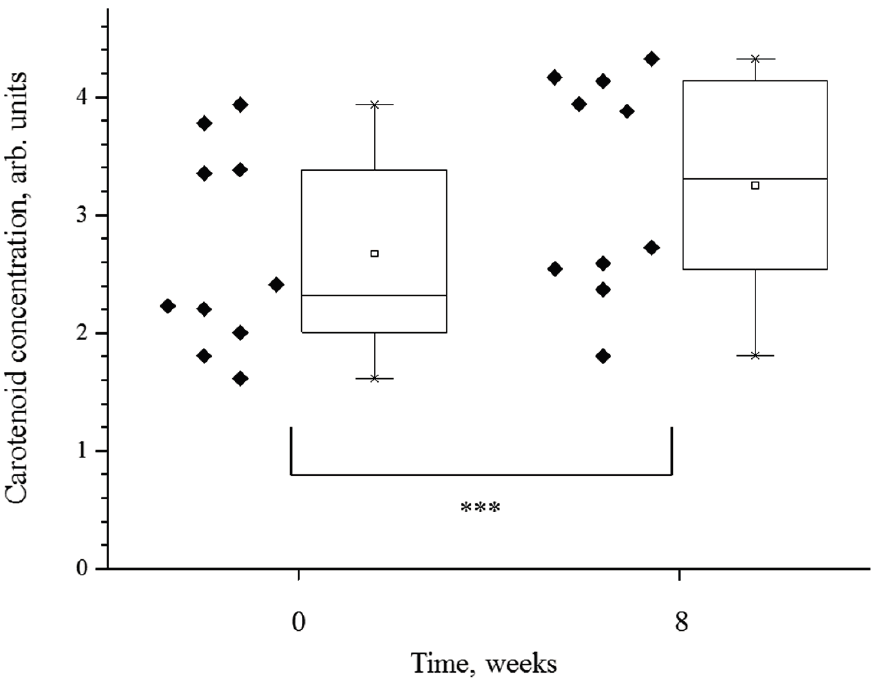
Figure 1. Boxplot of the changes in the carotenoid concentration prior to and subsequent to eight weeks of Spirulina platensis powder systemic application, *** p < 0.001. The box represents the middle 50% of carotenoid values including mean value and median.